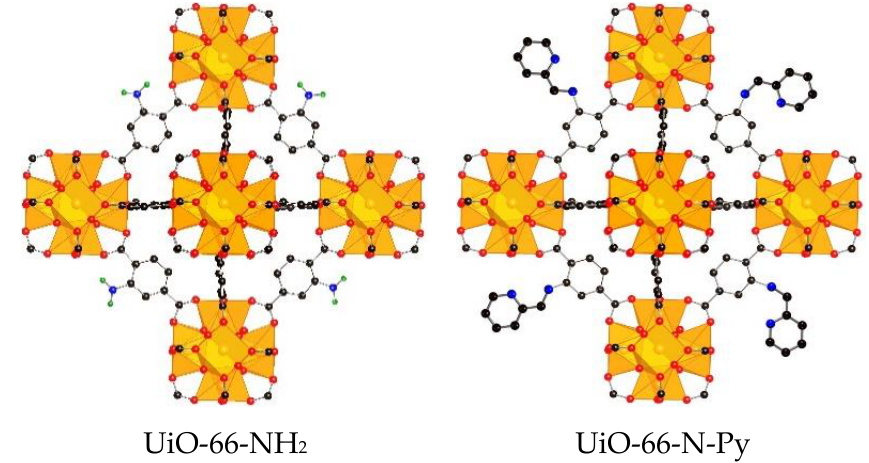
Figure 1. Schematic representation of UiO-66-NH 2 and UiO-66-N-Py.